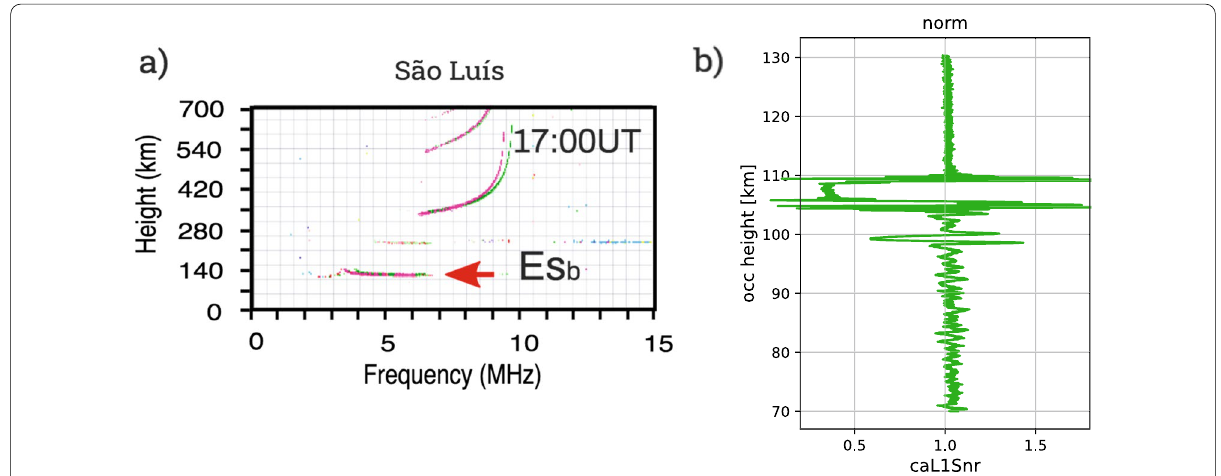
Fig. 2 a Ionogram of a strong sporadic E layer seen as an Esb at São Luís in the afternoon of 21 February 2021. Plot b shows a co-located (2.0 ◦ S, 43.5 ◦ W) normalized SNR profile including an intense Es signature. The RO sounding was recorded by COSMIC-2 satellite E2 at 17:05